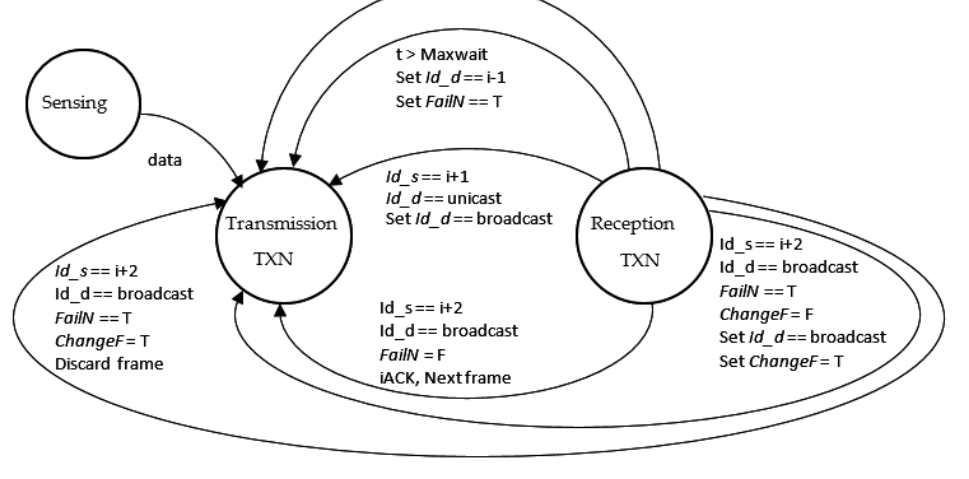
Figure 11. TXN node state diagram.